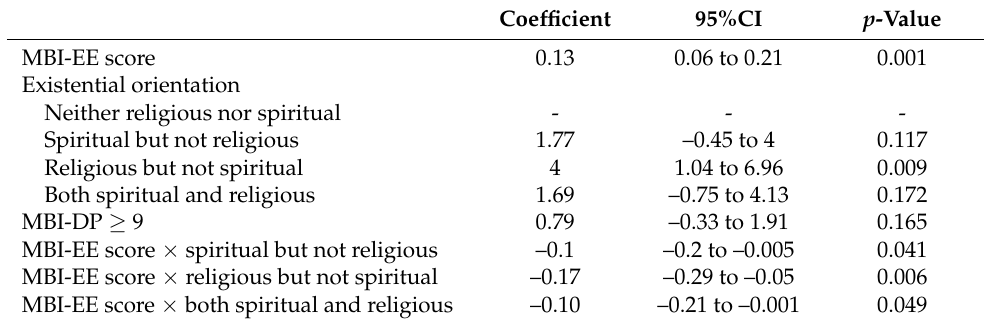
Table 4. Multivariate regression model with MDS-R as the dependent